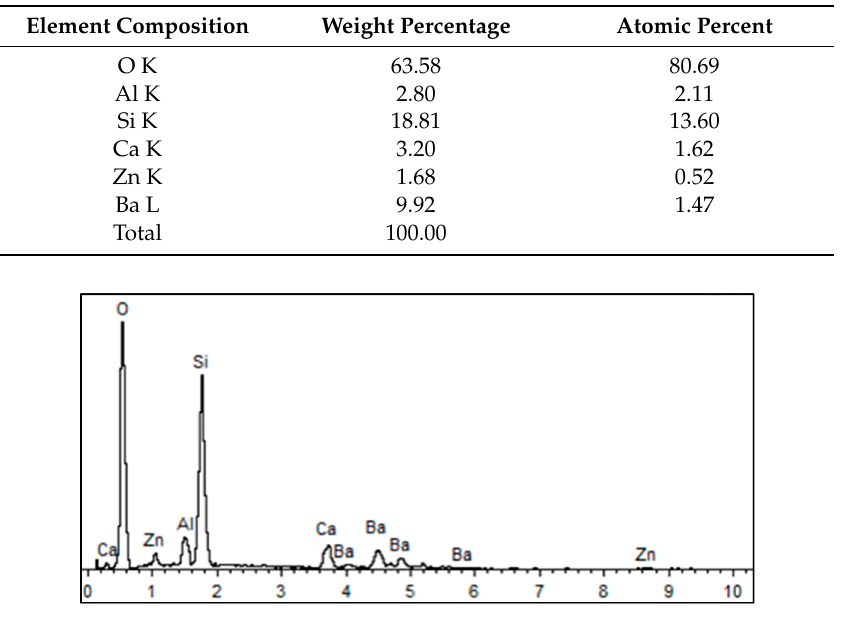
Table 1. Element composition of D-ZK3L glass.